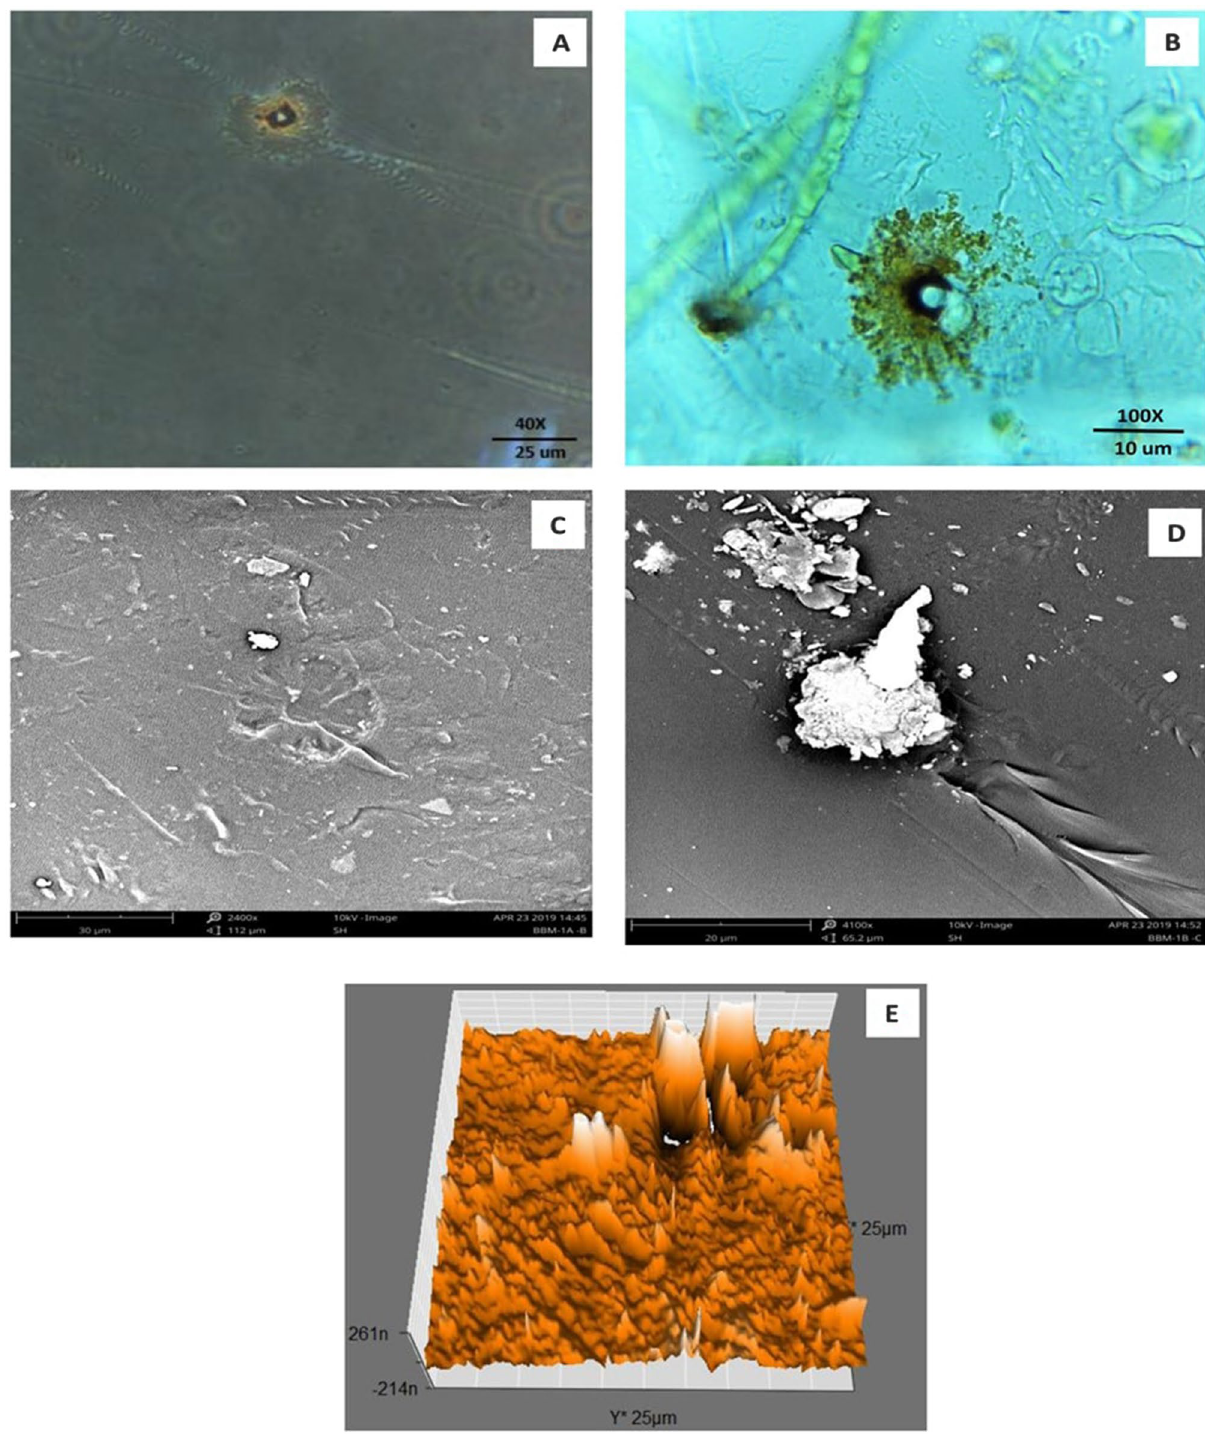
Figure 30. An eroded region on the surface of Uronema africanum treated LDPE sheet of different microscopical studies, such erosion was formed by the formation of the radial disc-like structure of the basal cell of the microalgal filament; ( A ) Dark field microscopy; ( B ) Light microscopy; ( C ) SEM image showing an impression caused by the formation the radial disc by the young germinating spore; ( D ) SEM image of an erosion caused by the formation of the disc by the microalga; ( E ) AFM image of the eroded